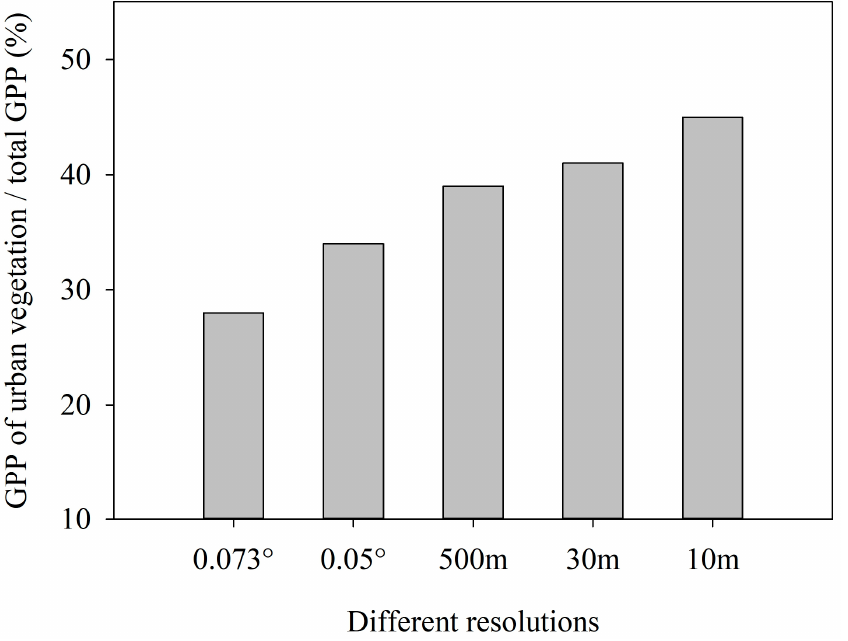
Figure 11. The contribution of urban forests to total GPP. The percentages of 0.073° and 0.05° are from Ju [51] and Zhang [50], respectively. Additionally, results of 500, 30, and 10 m resolutions were calculated by MODIS, Landsat-8 and Sentinel-2 in this study.